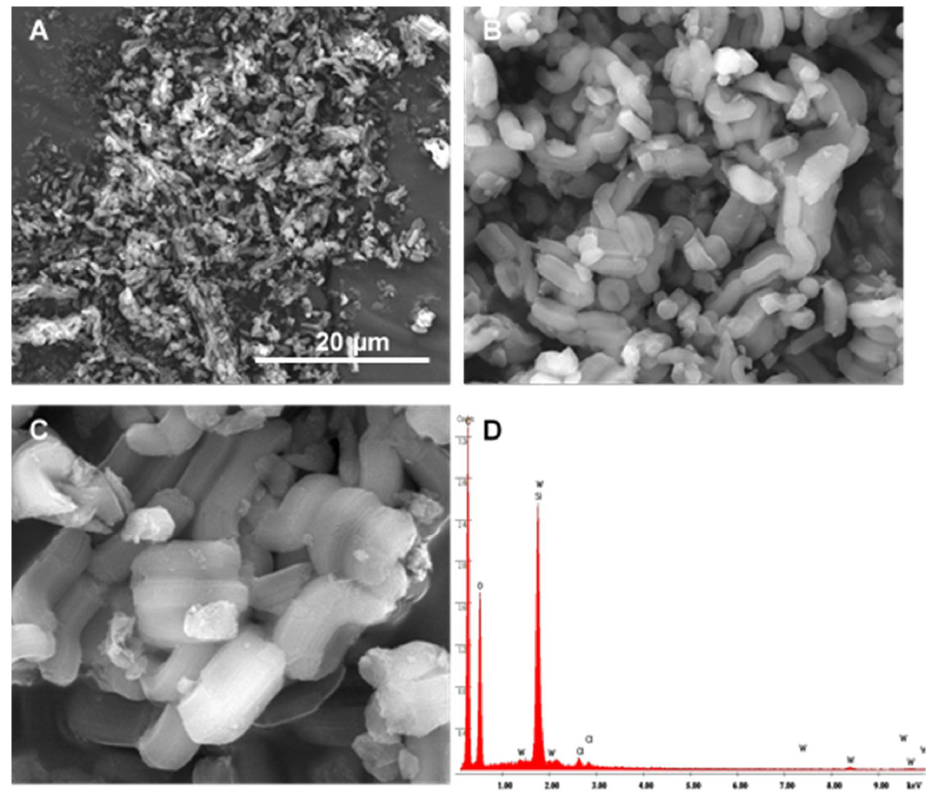
Figure 3. SEM images of the PW 12 @TM–SBA-15 composite material at different magnifications: ( A ) ×5000; ( B ) ×25,000; ( C ) ×60,000 and ( D ) energy dispersive X-ray spectroscopy (EDS) spectrum.